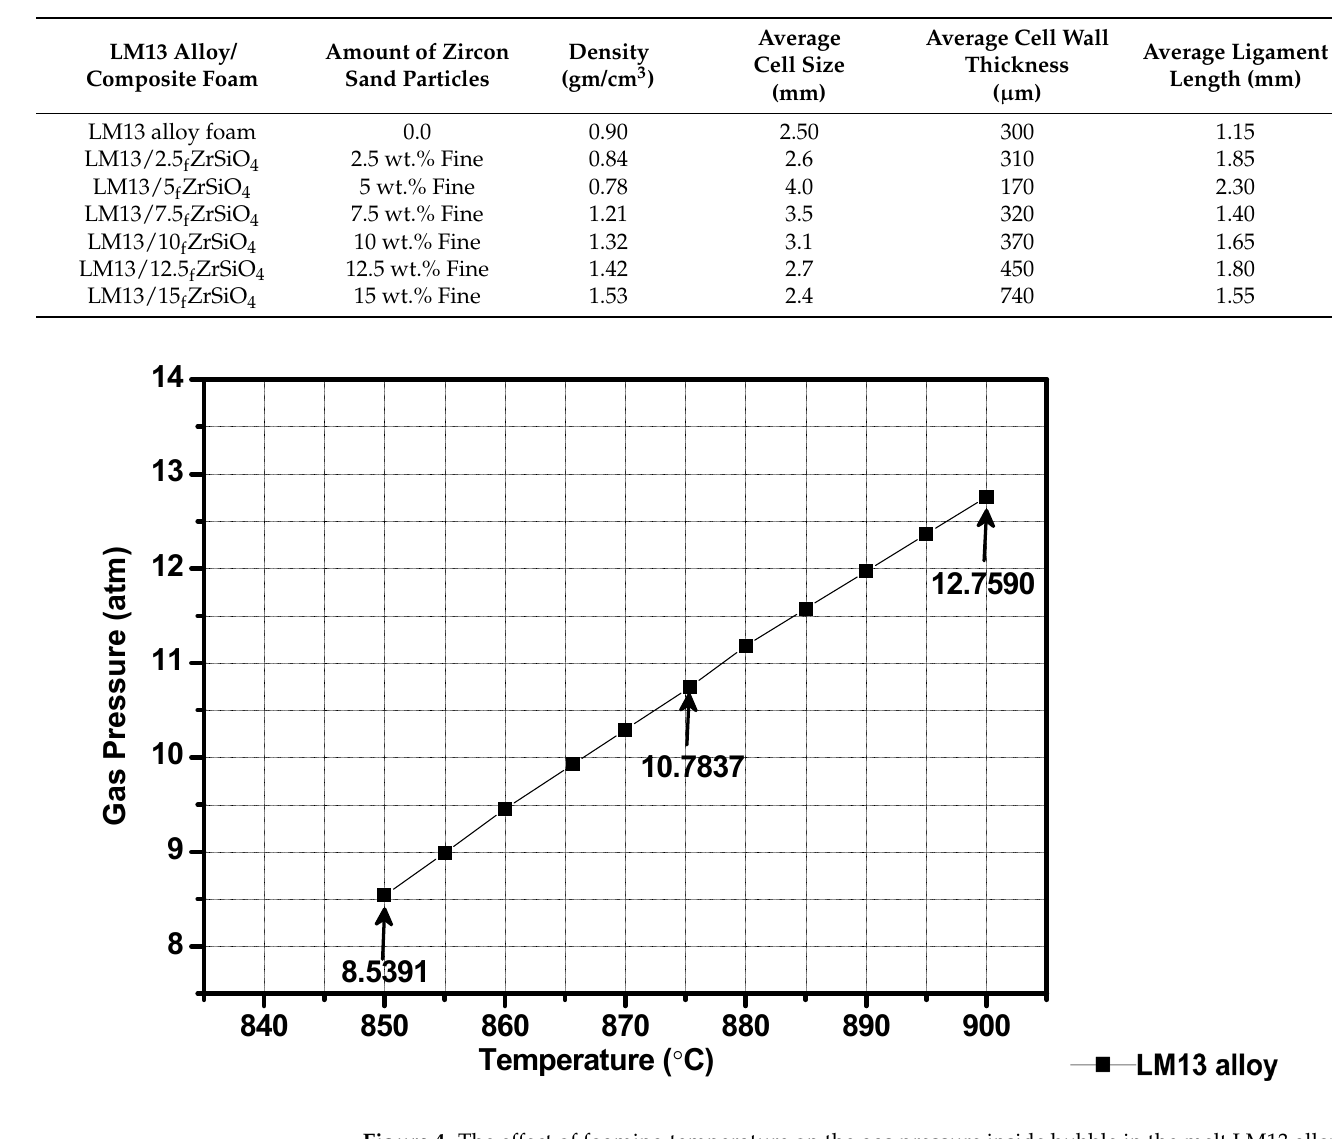
Figure 4. The effect of foaming temperature on the gas pressure inside bubble in the melt LM13